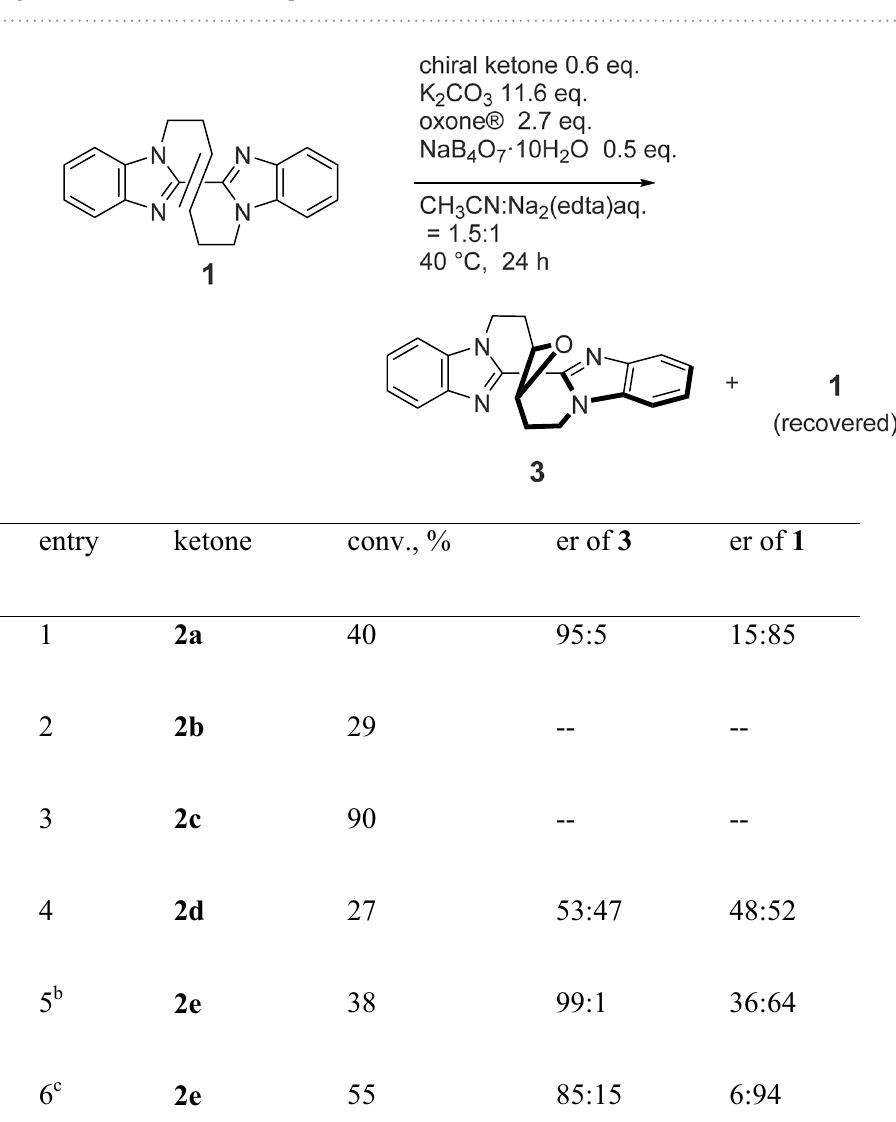
Figure 4. Chiral ketones for the precursor of dioxirane.